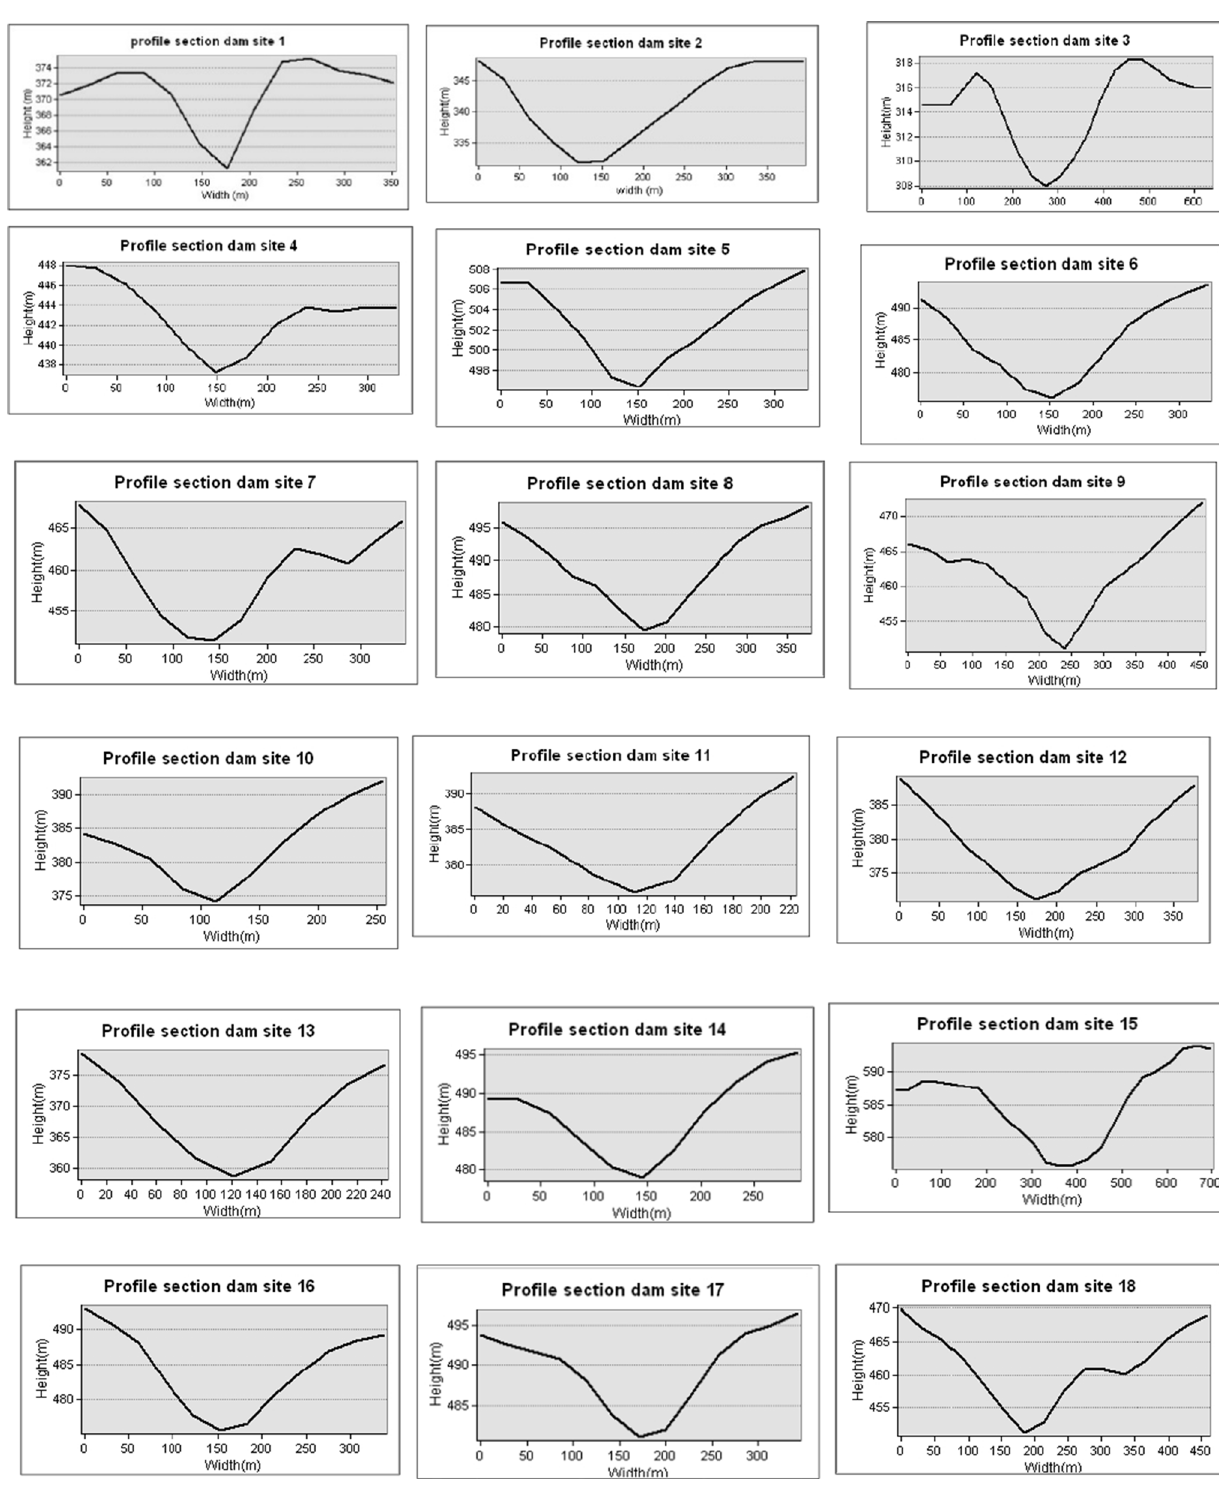
Fig. 11 Cross-sectional profile of all of the identified dam